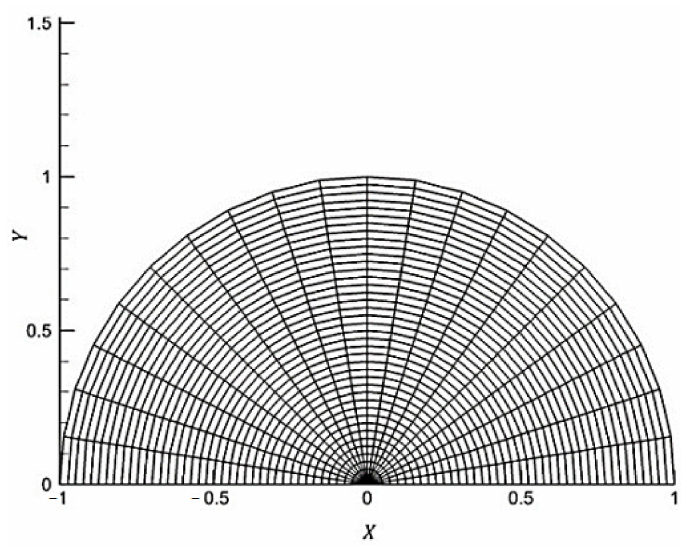
Figure 7. Generated grid in physical space for domain